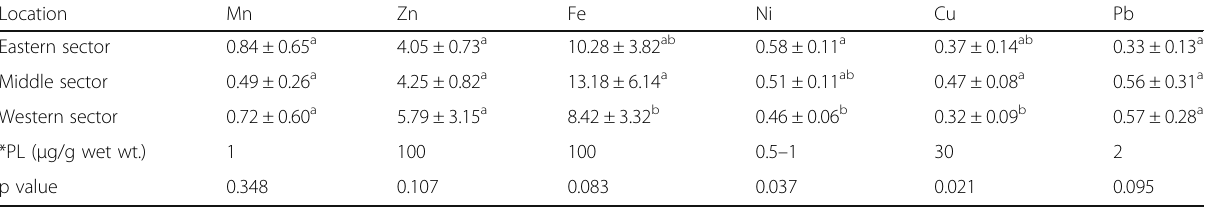
Table 7 Annual mean ± SD of heavy metals ( μ g/g wet wt.) in O. niloticus muscles from Burullus Lake